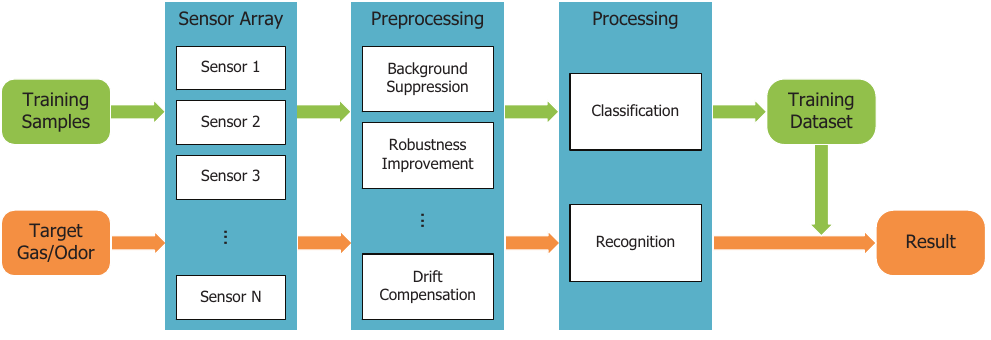
Figure 2. A typical scheme of machine